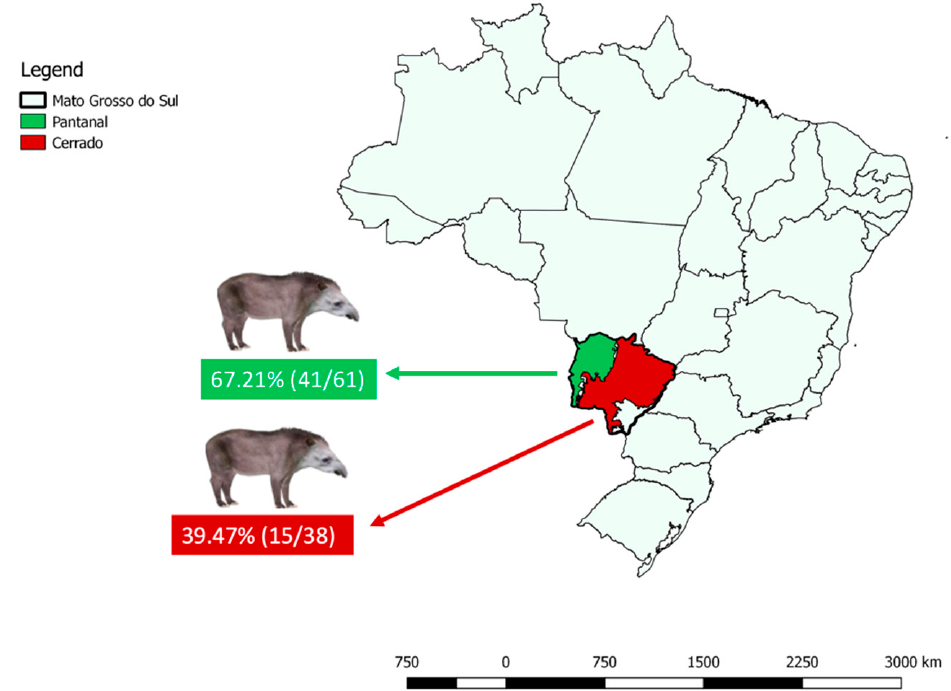
Figure 1. Number of tapirs from each biome that presented blood DNA samples with bands of expected sizes on agarose gel electrophoresis when tested for partial Piroplasmida 18S rRNA gene by nested PCR analysis [13] in Mato Grosso do Sul State. This map was constructed using QGis v. 3.26 software (http://qgis.org, accessed on 26 October